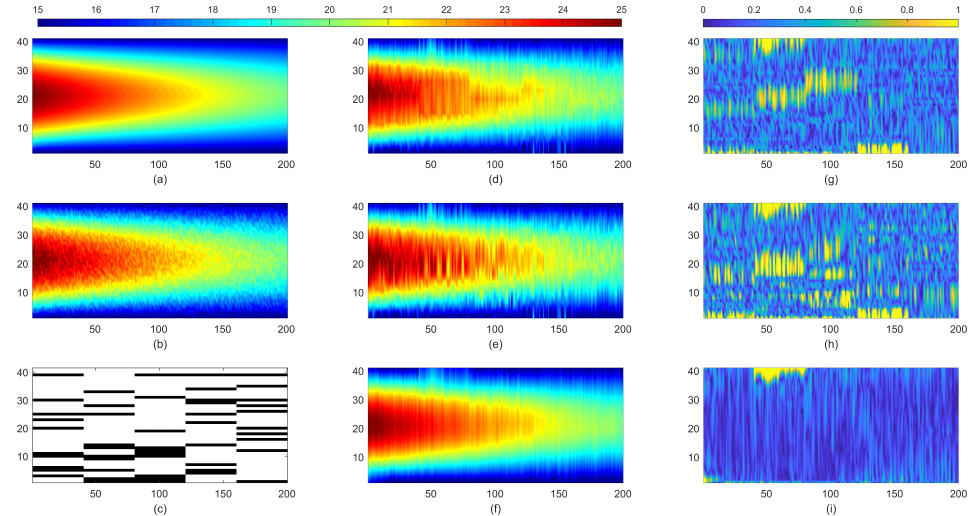
Figure 4. Heat diffusion data at 41 points and 200 time-steps: ( a ) Ground truth; ( b ) Noisy data derived from the real; ( c ) Sample of the noisy data; ( d ) Estimates using linear model; ( e ) Estimates using Kriging model; ( f ) Estimates using the proposed algorithm; ( g ) Deviation of the linear model estimate from the true value; ( h ) Deviation of the Kriging model estimate from the true value; and ( i ) Deviation of our model estimate from the true value.